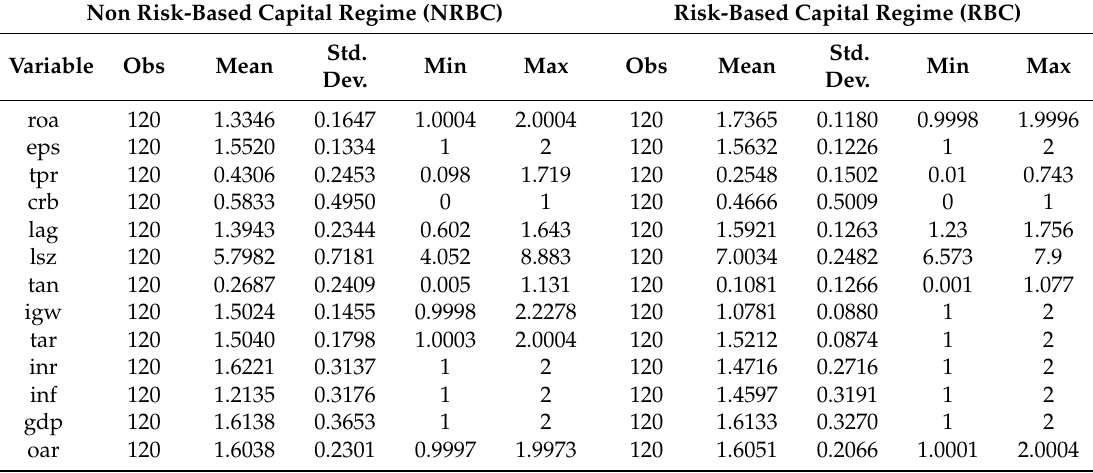
Table 2. Descriptive statistics of research variables between 1995–2002 and